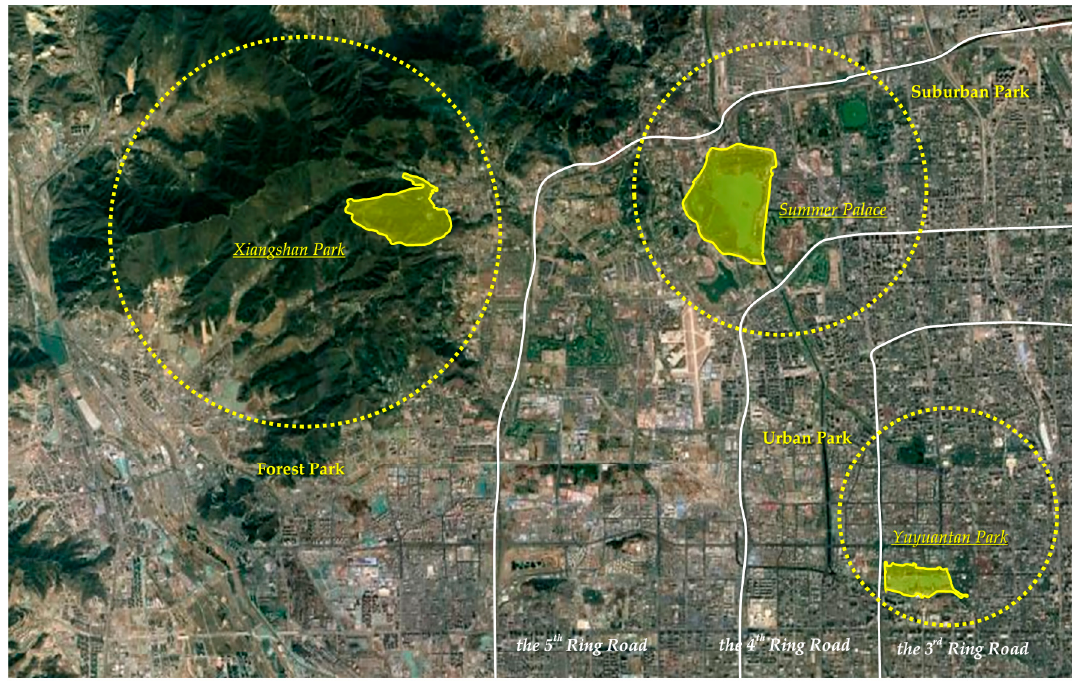
Figure 1. Research area of this study.